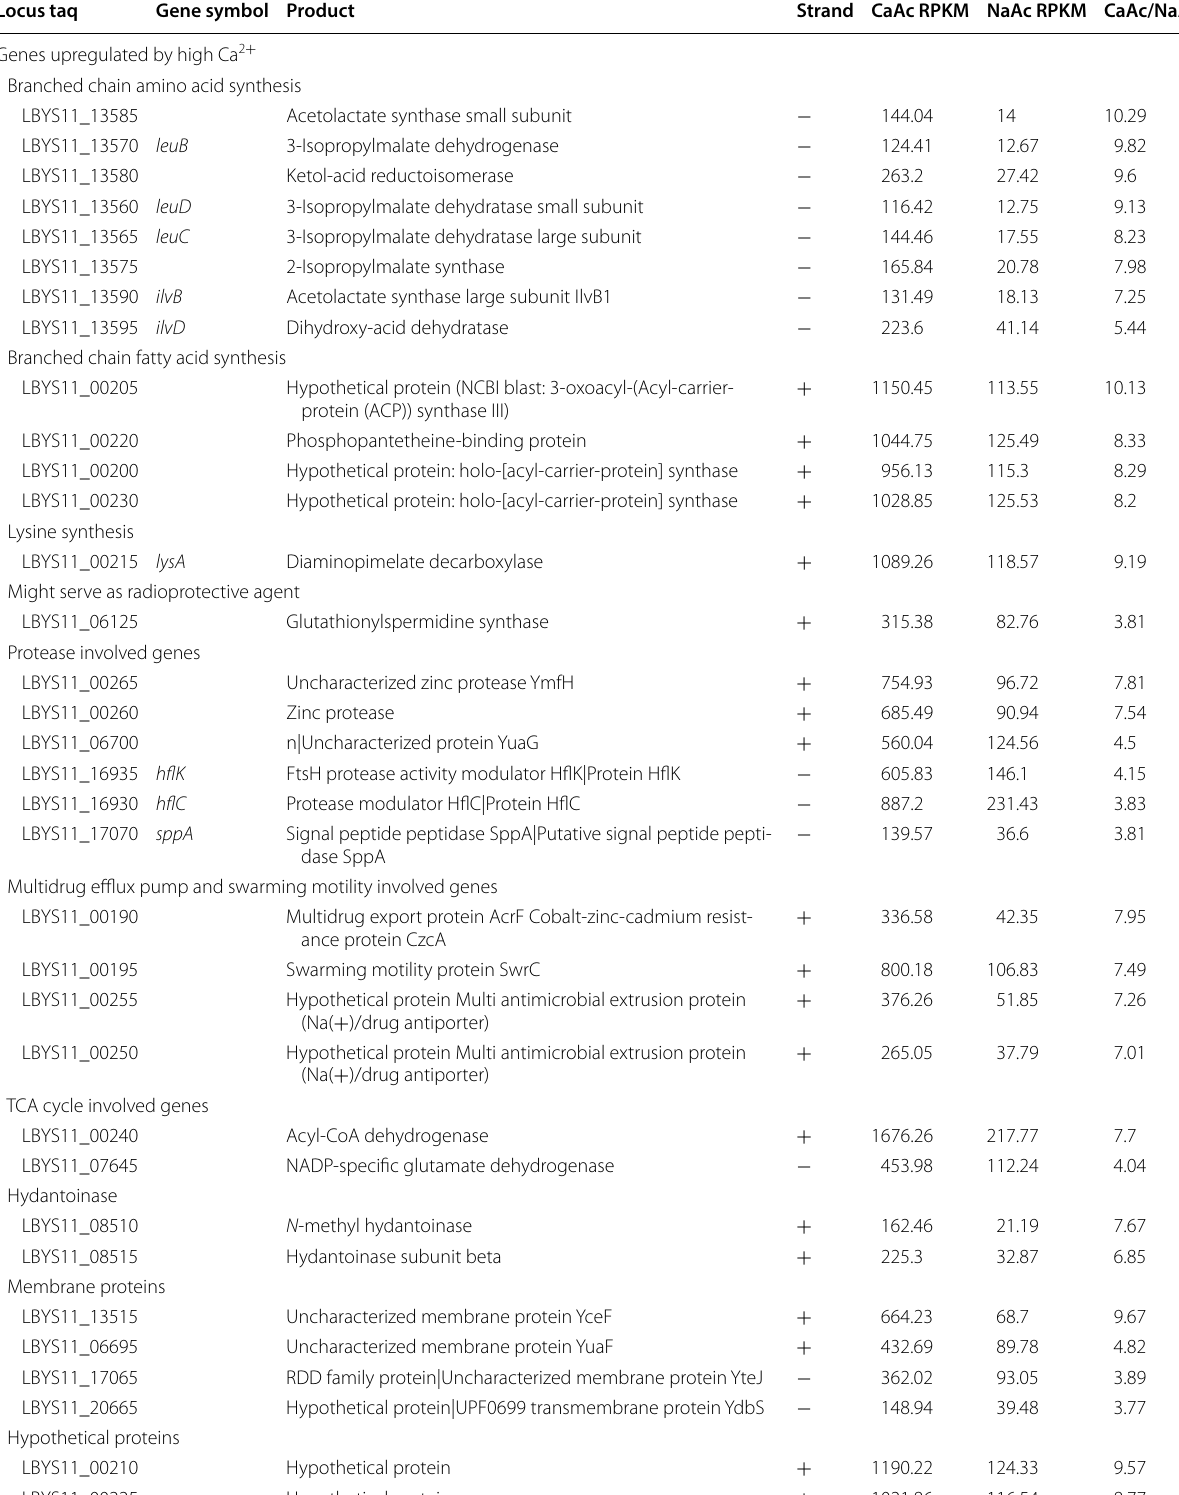
Table 4 Upregulated and downregulated genes in CaAc and NaAc condition (gene expression and p value .05) ≤ Locus